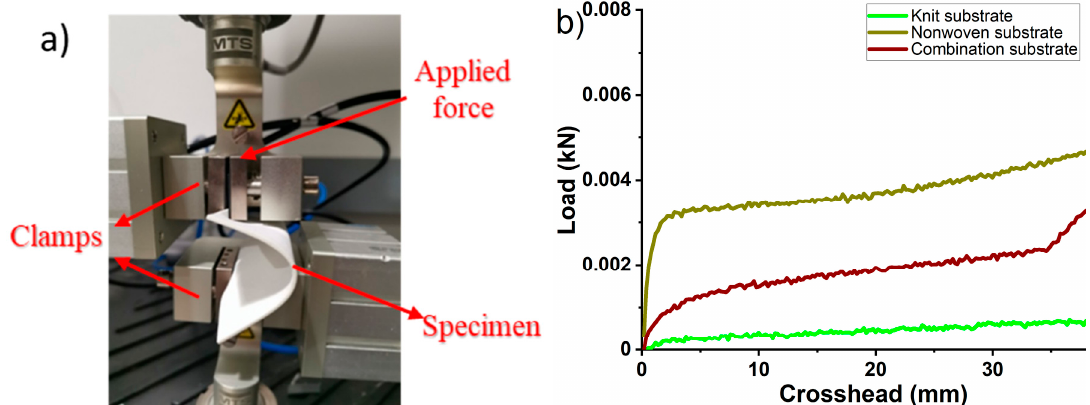
Figure 5. Buckling test of the nonwoven substrate (eight layers of nonwoven fabric), knit substrate (eight layers of knit fabric), and combination substrate (two layers of nonwoven fabric and six layers of knit fabric spray coated with BT dielectric ink). ( a ) Photography of experimental setup. ( b ) Buckling force displacement curve with fixed–fixed ends.